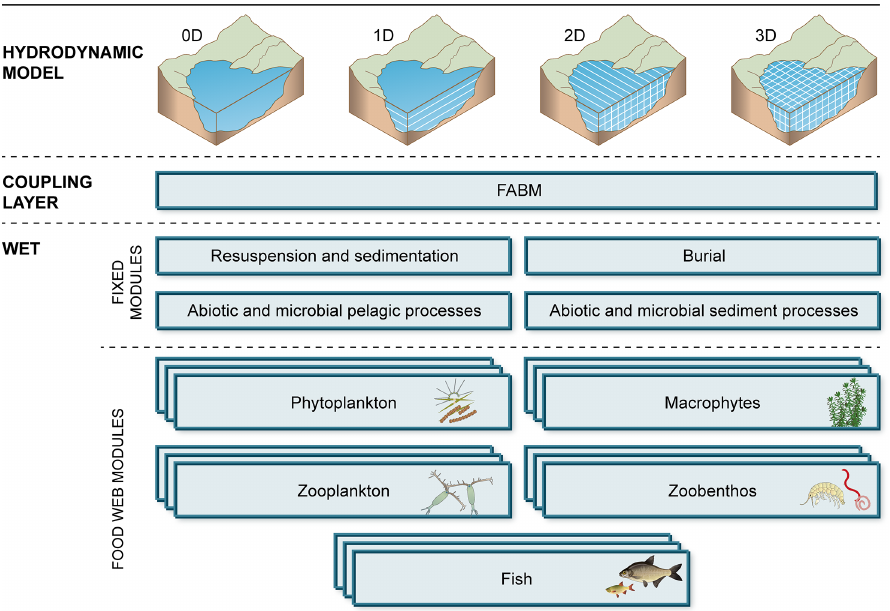
Figure 2. Functional structure of a WET setup. The ecological model WET is coupled to a physical driver model (of any dimensionality) through the coupling interface FABM. WET is partitioned into a number of fixed modules, handling microbial and chemical processes, and a flexible set of fully modularized food web modules, which can be duplicated and combined as